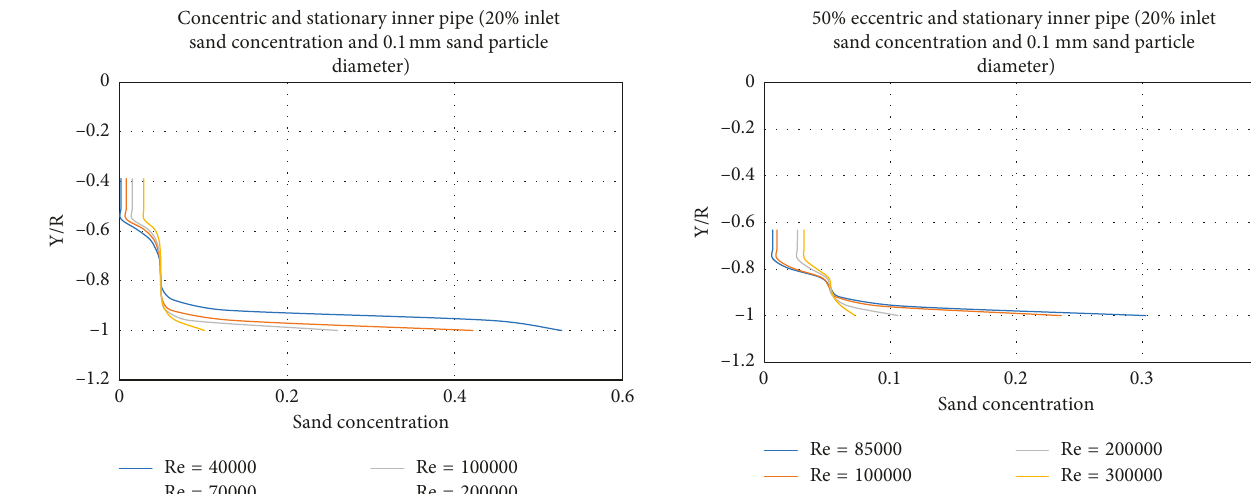
Figure 12: Effect of fluid flow on particle concentration profile (50% eccentric annuli with stationary inner pipe).